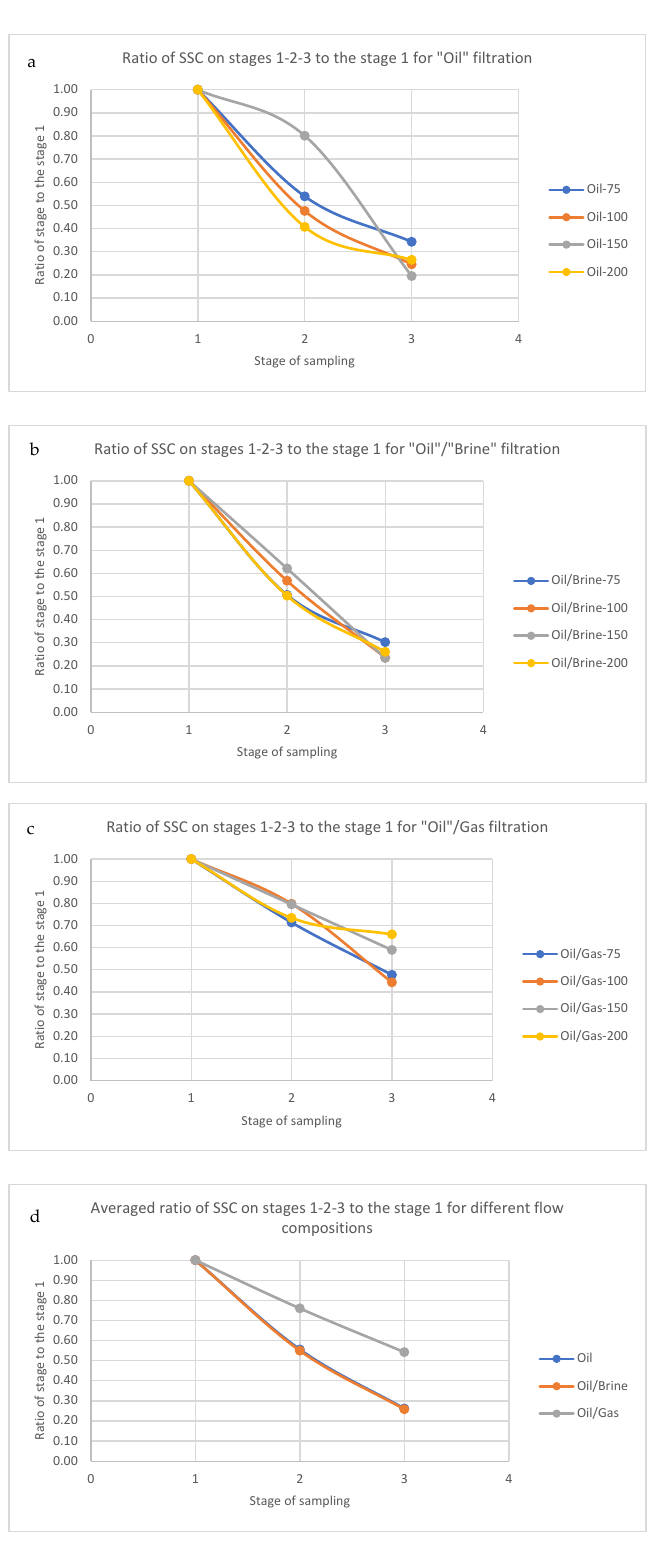
Figure 9. Stabilization rate between stages ( a – c ) and combined graph for phase distributions and its effect on stabilization ( d ) for PSD B.